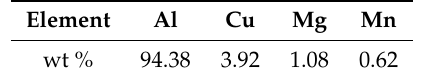
Table 3. The chemical composition of 2A12 in wt %.